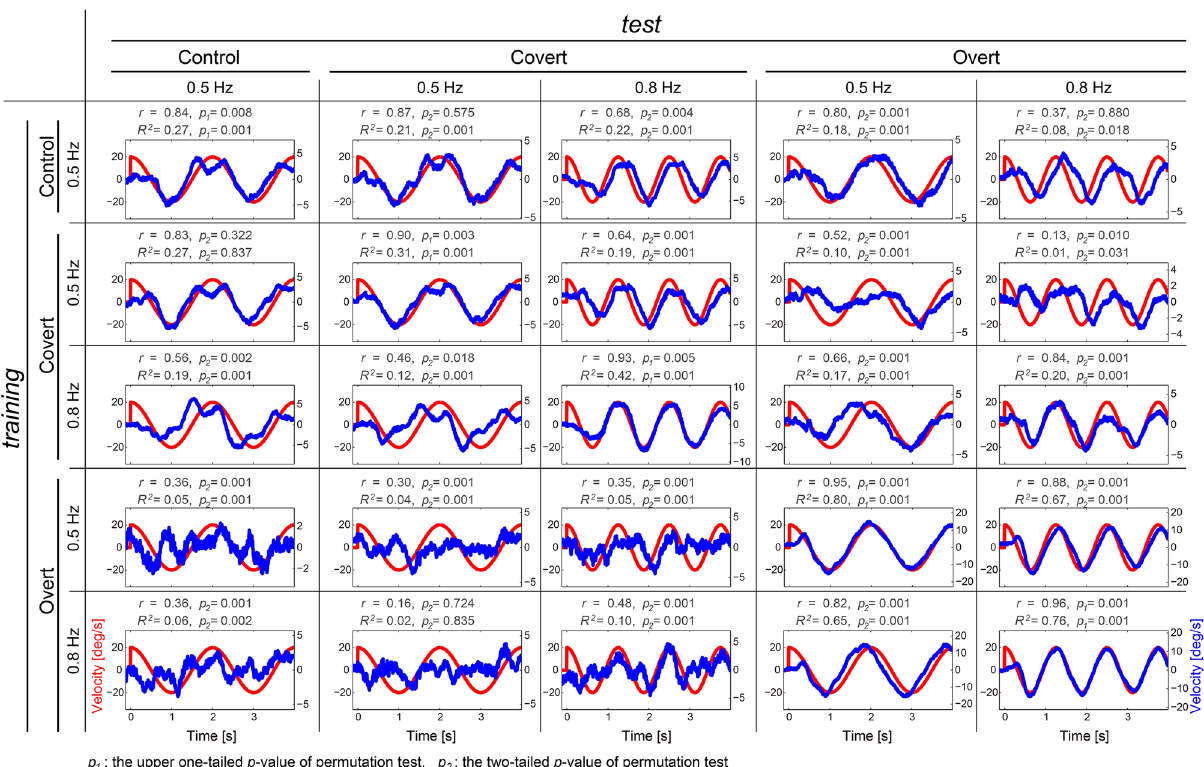
Figure 3. Trial-averaged values of predicted target velocities from cortical currents (example of a typical participant). Blue and red lines indicate predicted and true values,